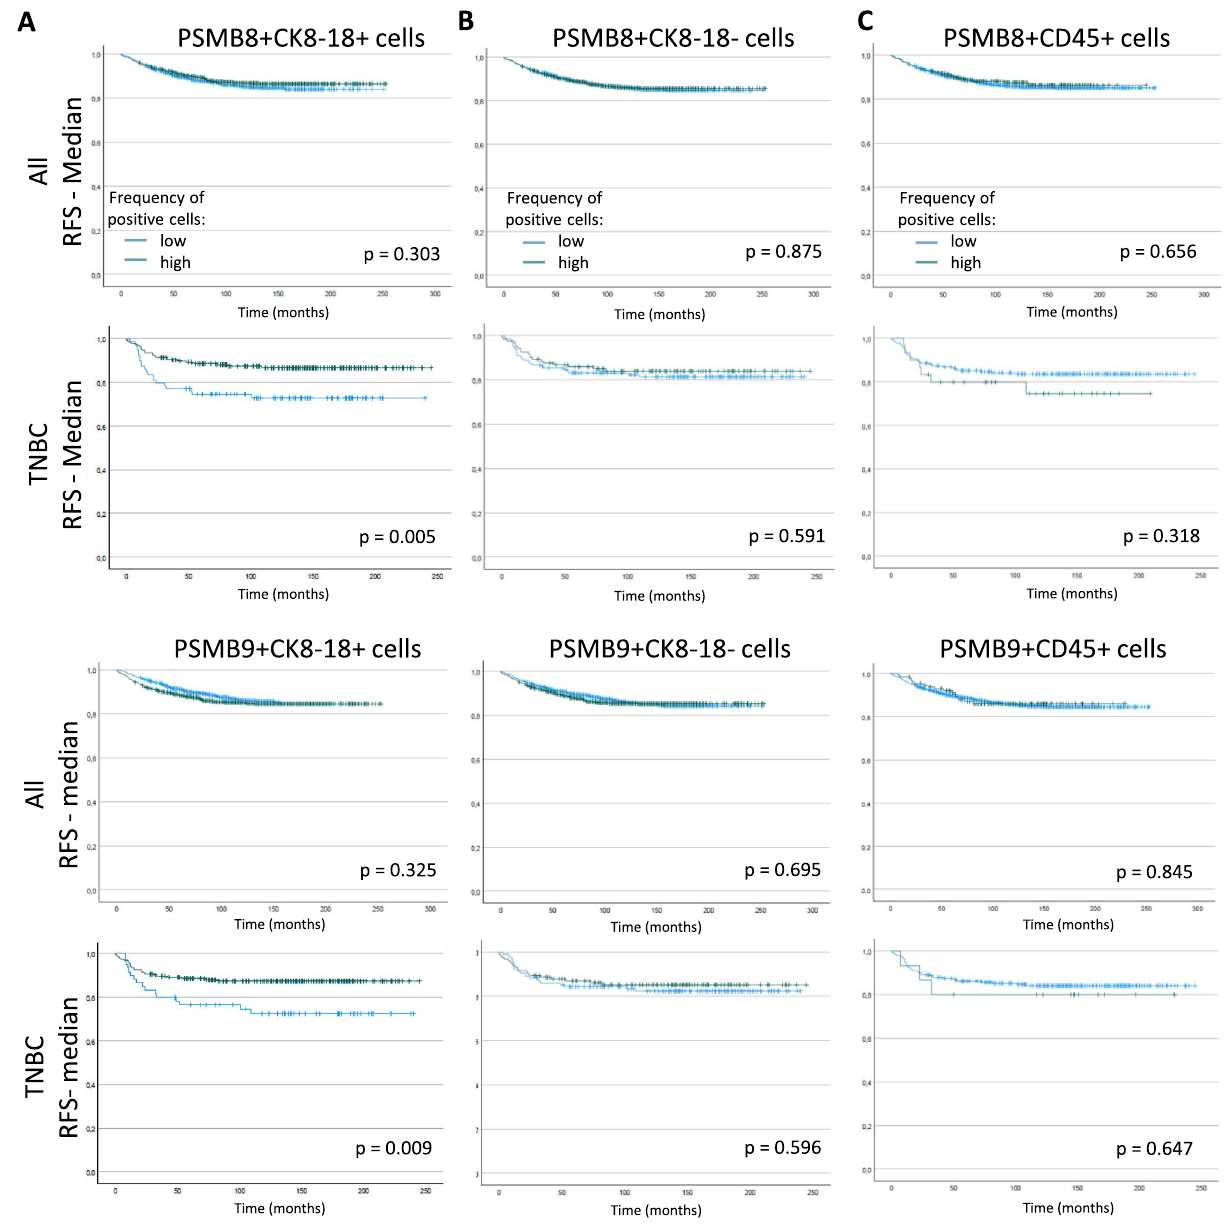
(CK8-18+), ( B ) stromal cells (CK8-18−) or ( C ) immune cells (CD45+) of all breast cancer subtypes together and TNBC samples. For ( A ) and ( B ), samples were divided according to their median number of cells and for ( C ), according to the presence or absence of CD45-expressing cells. The green and blue lines correspond to high and low frequency of positive cells, respectively. Statistical analyses by Logrank test: differences are considered statistically significant when p <